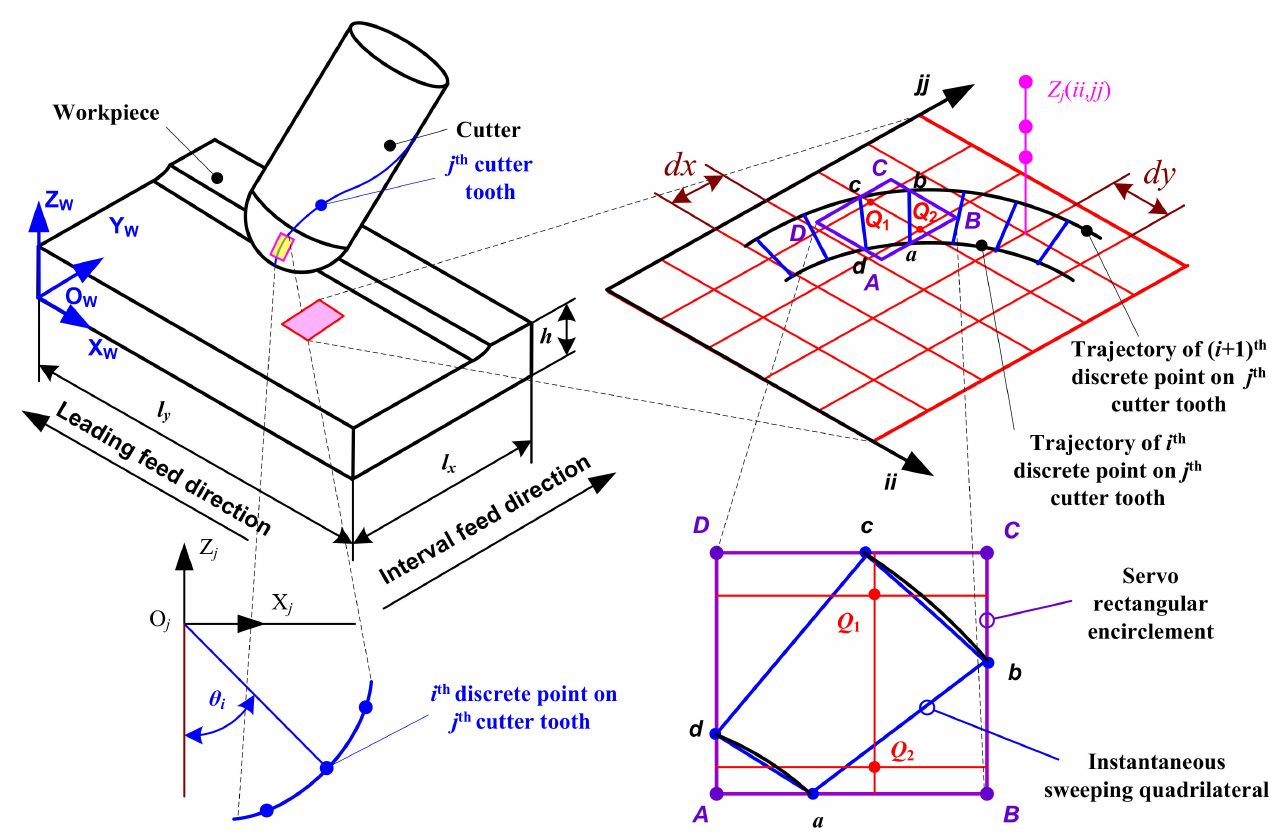
Figure 5. Ball-end milling micro surface topography generation principle.